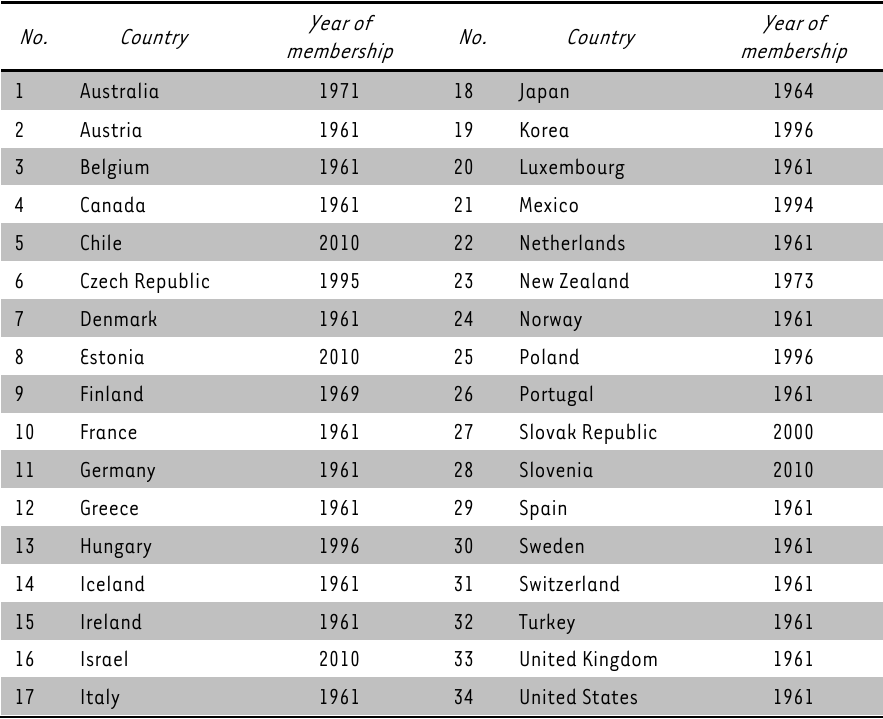
TABLE 1: OECD member countries No.